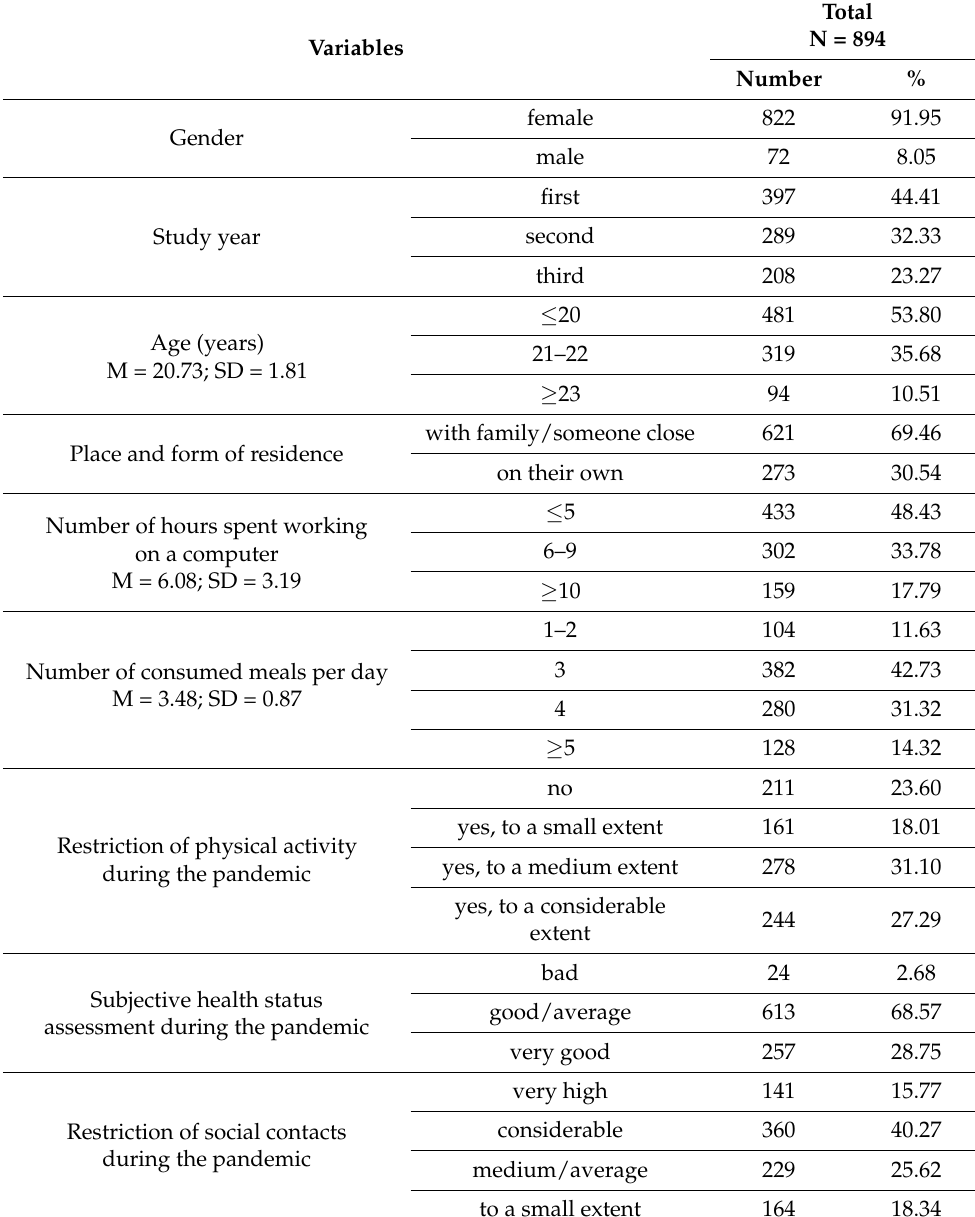
Table 1. Study group